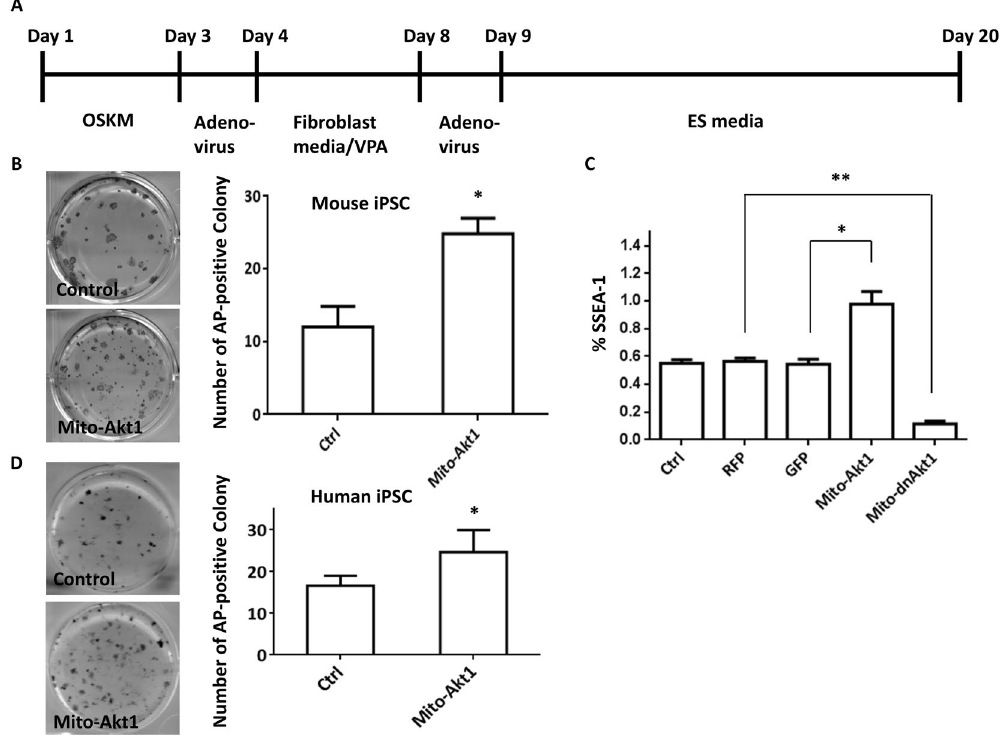
Figure 2. Mitochondrial Akt1 enhanced reprogramming of murine and human fibroblasts. ( A ) The scheme of iPSC induction procedure. O: Oct4. S: SOX2. K: Klf4. M: c-Myc. VPA: valporic acid. Detailed reprogramming protocol is described in the Materials and Methods. ( B ) The number of mouse iPSC colonies was determined by counting the number of alkaline phosphatase-positive colonies on day 20. Photos were taken from a 6 well plate from each group. Representative photo of AP staining is shown here. Bar graph represents the results summarized from 3 independent experiments in triplicates. * p < 0.0001. ( C ) Reprogramming efficiency analyzed by SSEA1 positive cells. Mito-Akt1 significantly increased the number of cells stained positive for SSEA1, while Mito-dnAkt1 reduced SSEA1 staining to background level. Ctrl: control media. RFP: lenti-RFP virus. GFP: Ad-GFP virus. The percentage of SSEA1-positive cell was determined by flow cytometry on day 21. Bar graph represents the results summarized from 3 independent experiments in triplicates. * p < 0.005, ** p < 0.0001. ( D ) The number of human iPSC colonies was determined by counting the number of alkaline phosphatase-positive colonies in each well on day 20. Representative photo of AP staining is shown here. Bar graph represents the results summarized from 3 independent experiments in triplicates. * p <